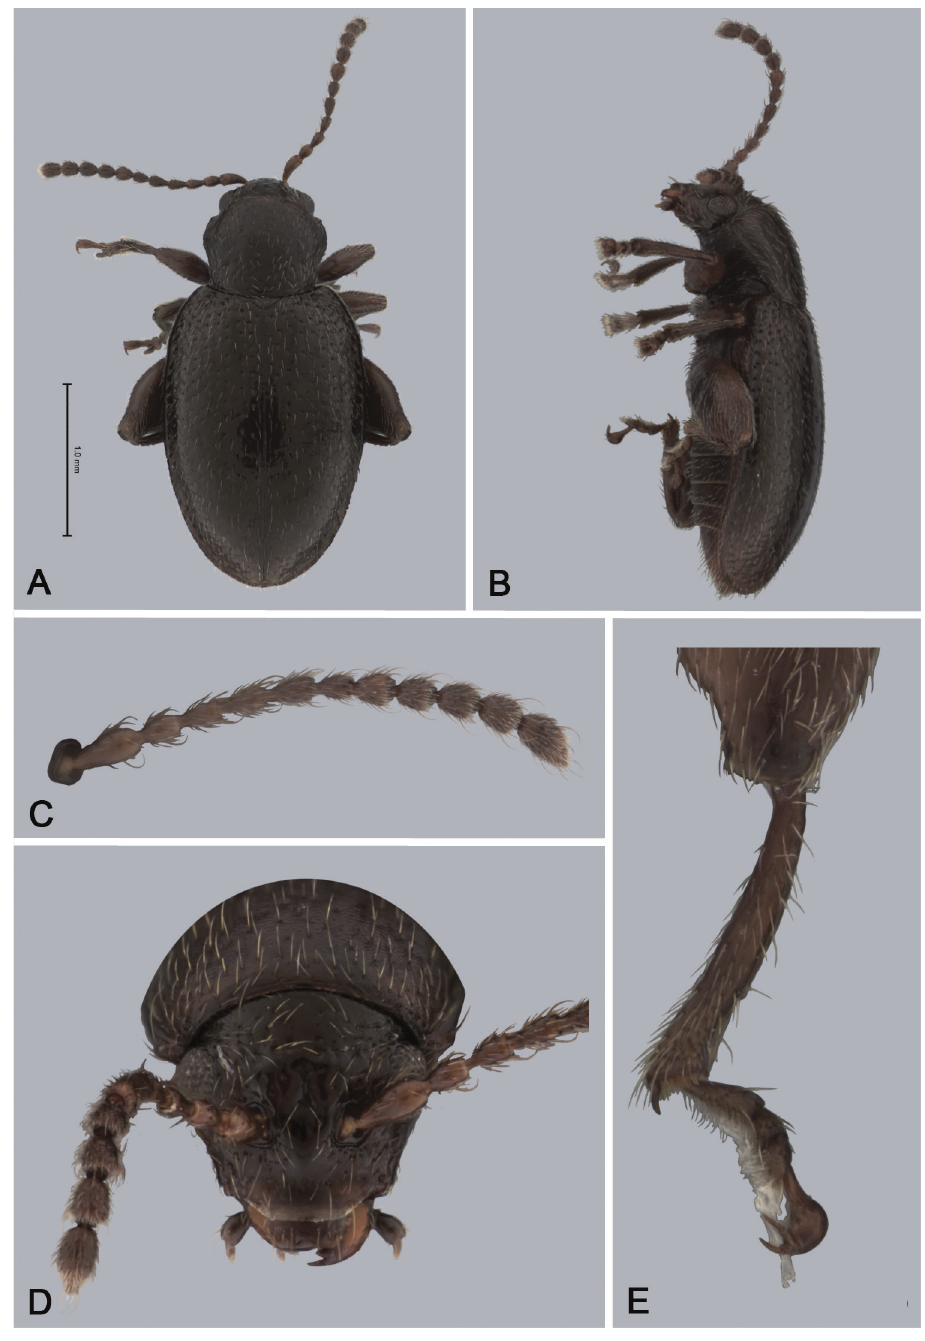
Figure 12. Andersonoplatus jolyi . A Habitus dorsal B Habitus lateral C Antenna D Head, frontal view E Hind